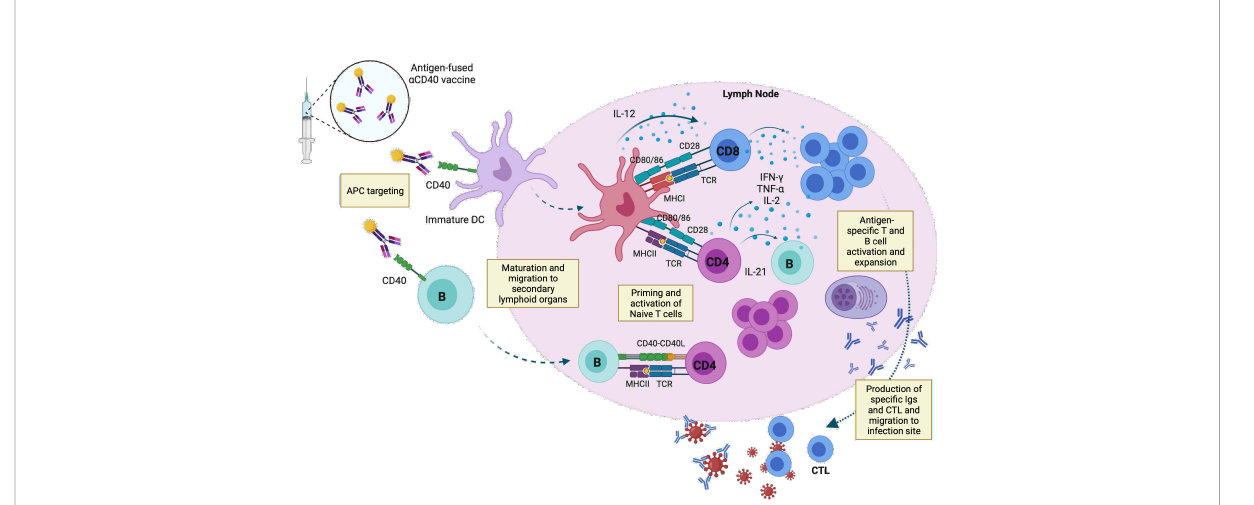
FIGURE 2 Capture of the anti-CD40 vaccine by APCs and activation of T- and B-cell responses in the draining lymph node. Targeted vaccines recognize CD40 molecules expressed on the surface of immature DCs and B-cells. The vaccine induces the maturation and migration of the immune cells to secondary lymphoid organs, where they present the peptides to naïve T-cells through MHC-I and -II complexes. Mature DC release IL- 12, which stimulates the differentiation and expansion of T-cells, which in turn release pro-in fl ammatory cytokines such as IFN- g , TNF a or IL-2, promoting the activation of cytotoxic T-cells. B-cells can also present the antigen to naïve CD4 + T-cells through CD40-CD40 ligand, inducing maturation and proliferation of antigen speci fi c T-cells, which trigger B-cell maturation by IL-21. Antigen speci fi c antibodies and T-cells migrate to the infection site to neutralize the virus and face the pathogen. APC, antigen-presenting cells; IL, interleukin; CTL, Cytotoxic T lymphocyte; TCR, T-cell receptor. This image was created with BioRender